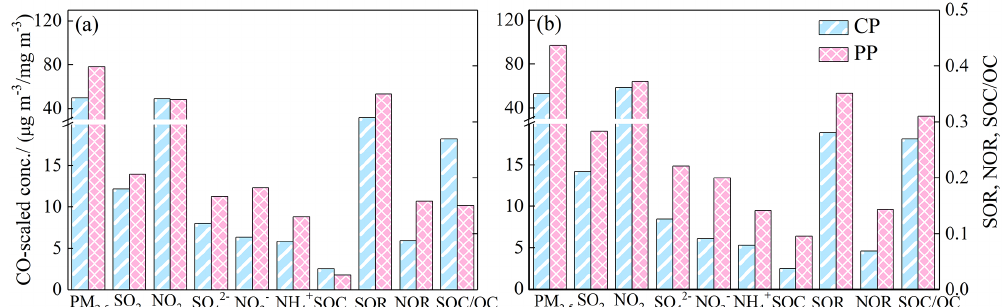
Figure 7. CO-scaled concentrations of various pollutants and the values of SOR, NOR, and SOC / OC in winter at CD (a) and CQ (b) . CP and PP are from the same period as Fig.